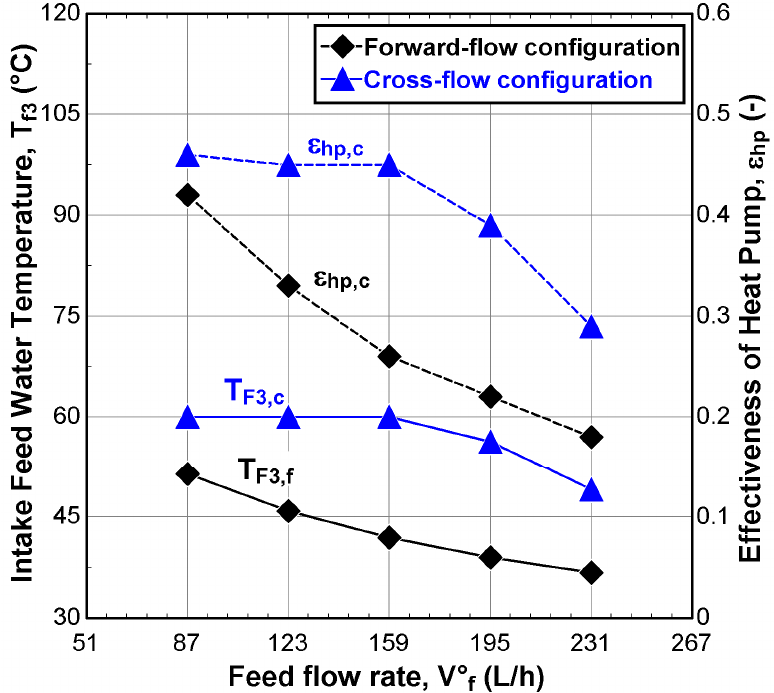
. v F 3 on the feed water temperature and the effectiveness of Figure 10. Effect of the feed water flow, Figure 10. Effect of the feed water flow, 𝑣(cid:4662) (cid:3007)(cid:2871) on the feed water temperature and the effectiveness of . . v H 1 = 900 L/h, T H 1 = 75 ◦ C, v C 1 = 405 L/h, T C 1 = 20 ◦ C, C F 3 = 1260 ppm, and the heat pump system ( the heat pump system ( 𝑣(cid:4662) (cid:3009)(cid:2869) = 900 l/h, T (cid:3009)(cid:2869) = 75 °C, 𝑣(cid:4662) (cid:3004)(cid:2869) = 405 l/h, T (cid:3004)(cid:2869) = 20 °C, 𝐶 (cid:3007)(cid:2871) = 1260 ppm, and 𝑃 (cid:3049) = 11.5 kPa). P v = 11.5